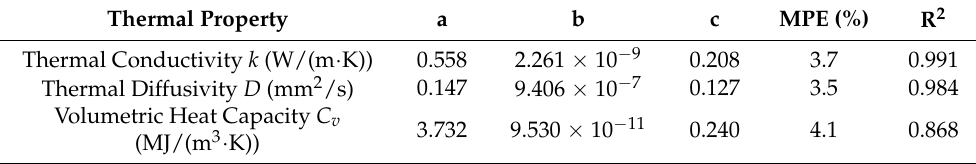
Table 4. Regression coefficients, R 2 and mean percentage error (MPE) of the model for brain tissue.